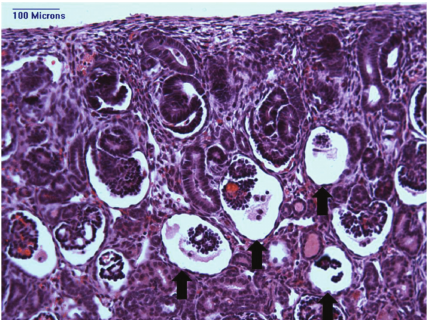
Figure 3: A representative photomicrograph of a histological renal section showing morphologically abnormal glomeruli (with enlarged Bowman’s spaces and shrunken glomerular tufts) in the outer renal cortex of a preterm baboon kidney (indicated by